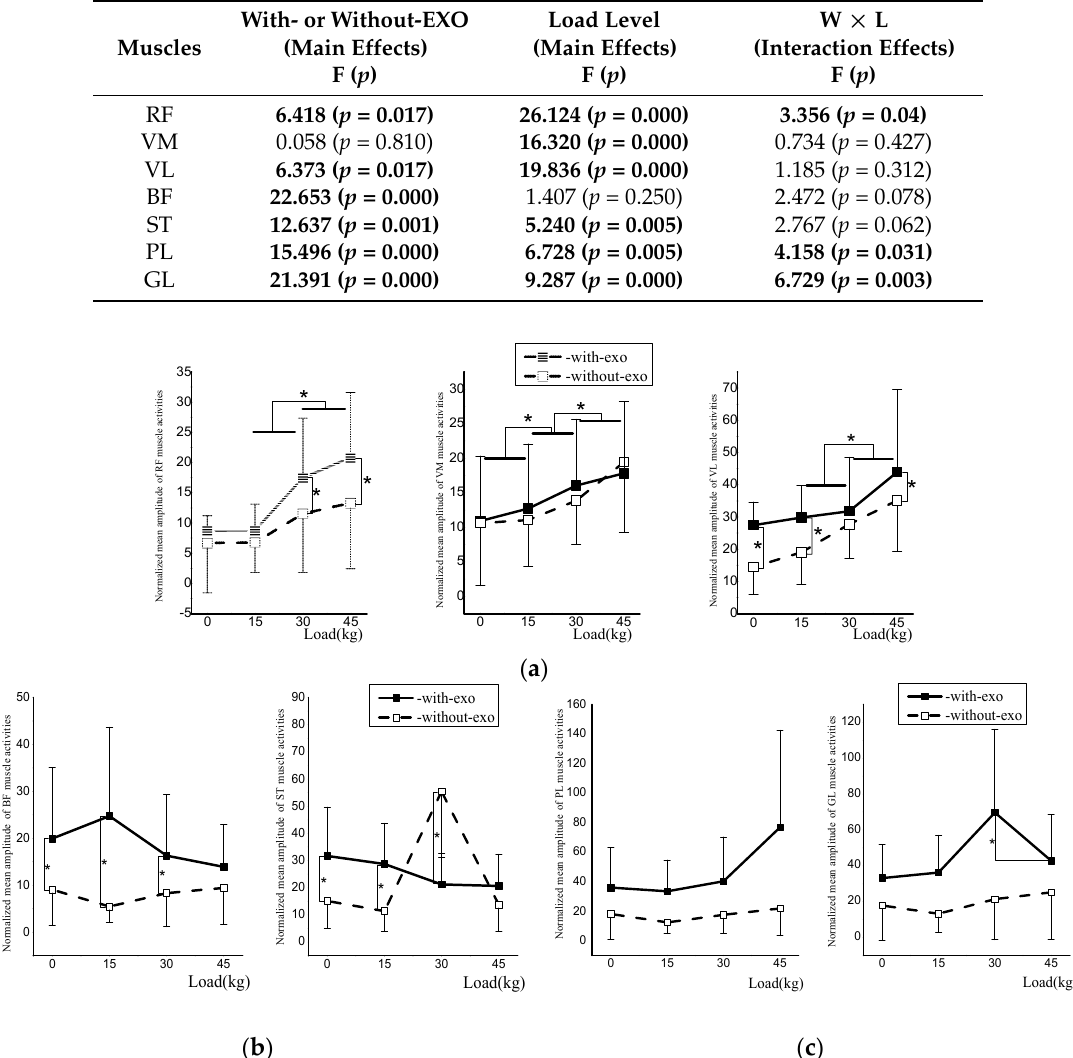
Table 3. Summary of Two-Way ANOVA Results for the Main and Interaction Effects of With or Without and Load Final EMG Values. W × L stands for with or without and load interaction. F means F test value. Lower-case p means statistical significance and the significant differences were bolded.